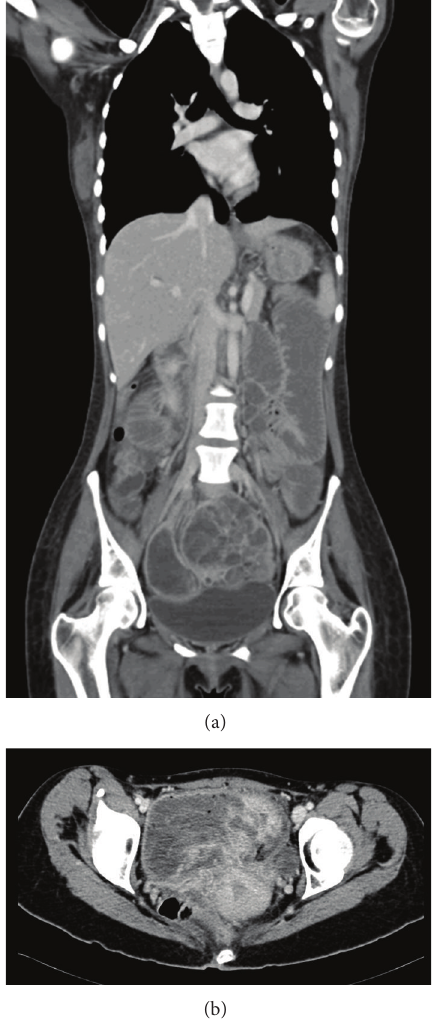
Figure 1: Computed tomography (CT) of the abdomen. (a) Coronal sectionand(b)axialsectionshowingahuge 12.8×10.2×13.1 cmhet- erogeneous, aggressive-looking intraperitoneal pelvic mass lesion, most likely arising from intestinal ileum, with areas of lobulations, hemorrhagic cystic changes, gas locules, fluid-fluid levels, and proximal small bowel dilatation due to partial